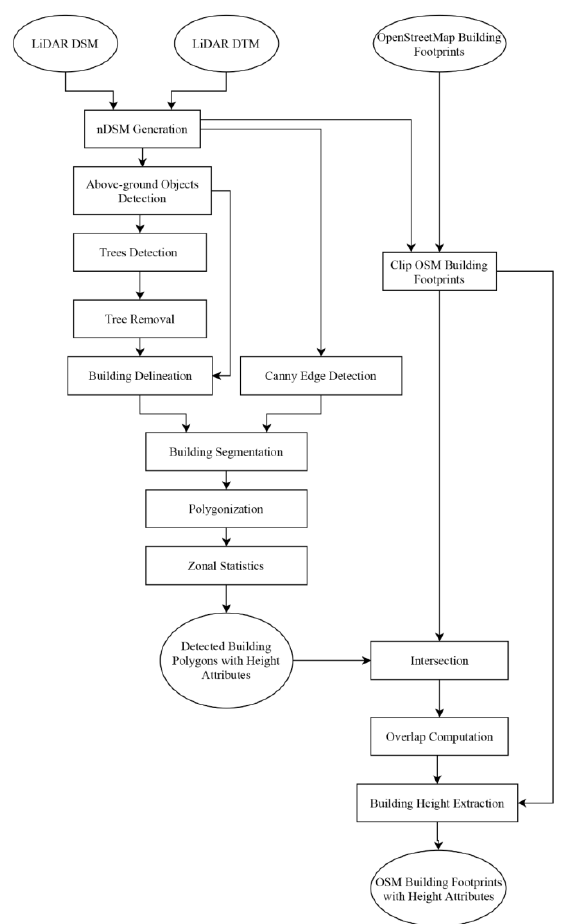
Figure 2. LOD1 Building Reconstruction